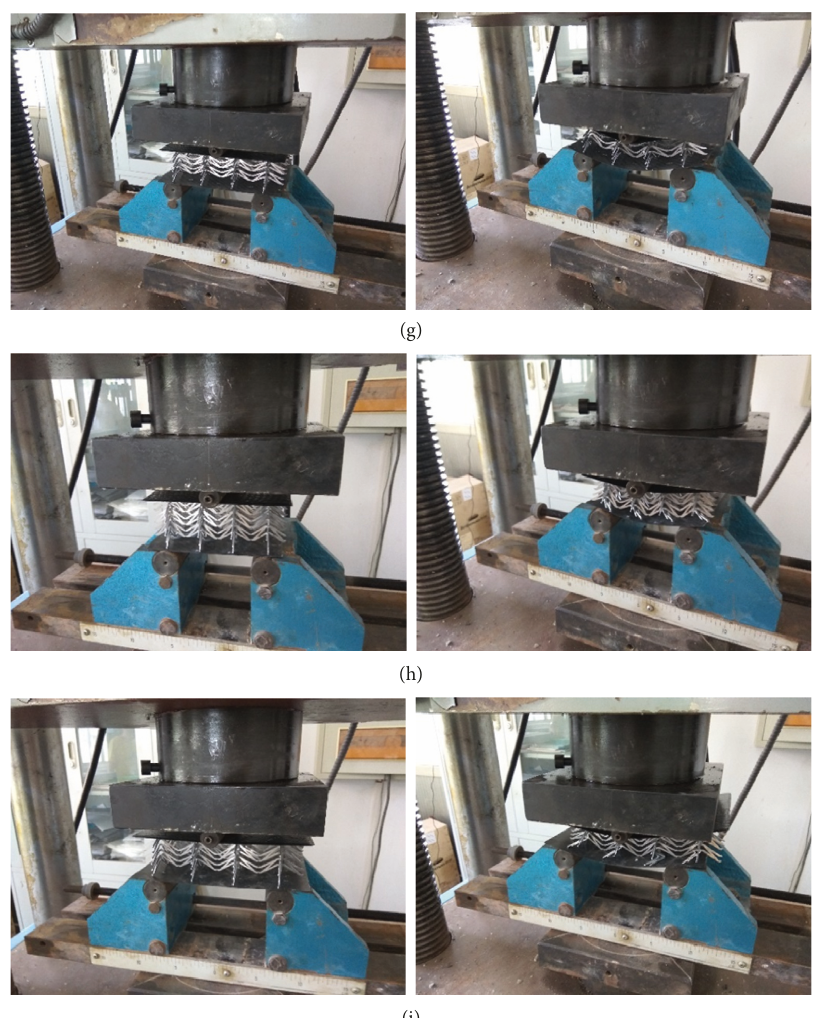
Figure 8: Comparison of samples before and after experiments. (a) Sample 1 before and after experiment. (b) Sample 2 before and after experiment. (c) Sample 3 before and after experiment. (d) Sample 4 before and after experiment. (e) Sample 5 before and after experiment. (f) Sample 6 before and after experiment. (g) Sample 7 before and after experiment. (h) Sample 8 before and after experiment. (i) Sample 9 before and after